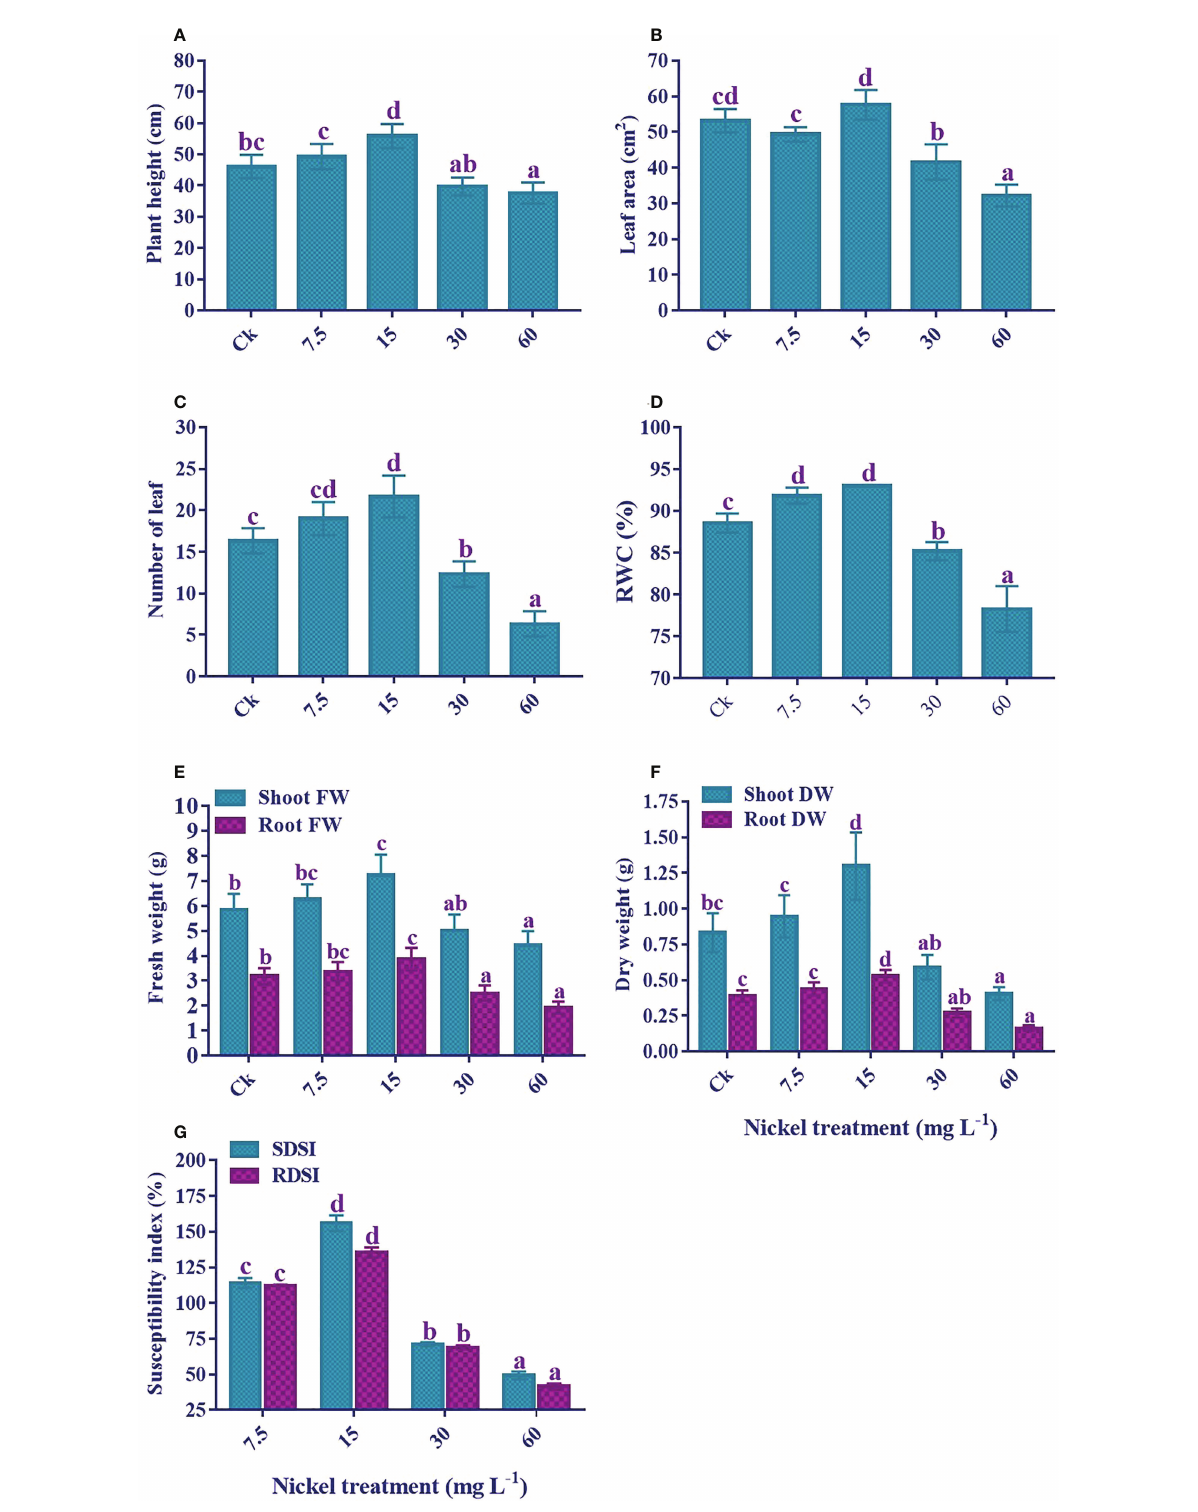
FIGURE 2 Effect of different Ni treatments on growth, biomass, and susceptibility index of sweetpotato. (A) Plant height, (B) Leaf area, (C) Number of leaf, (D) relative water content, (E) fresh weight of the plant, (F) dry weight of the plant, and (G) shoot and root dry weight susceptibility index. According to the Duncan test, different letters indicate a signi fi cant difference (p < 0.05) among the fi ve treatments. The error bars represent the mean ±